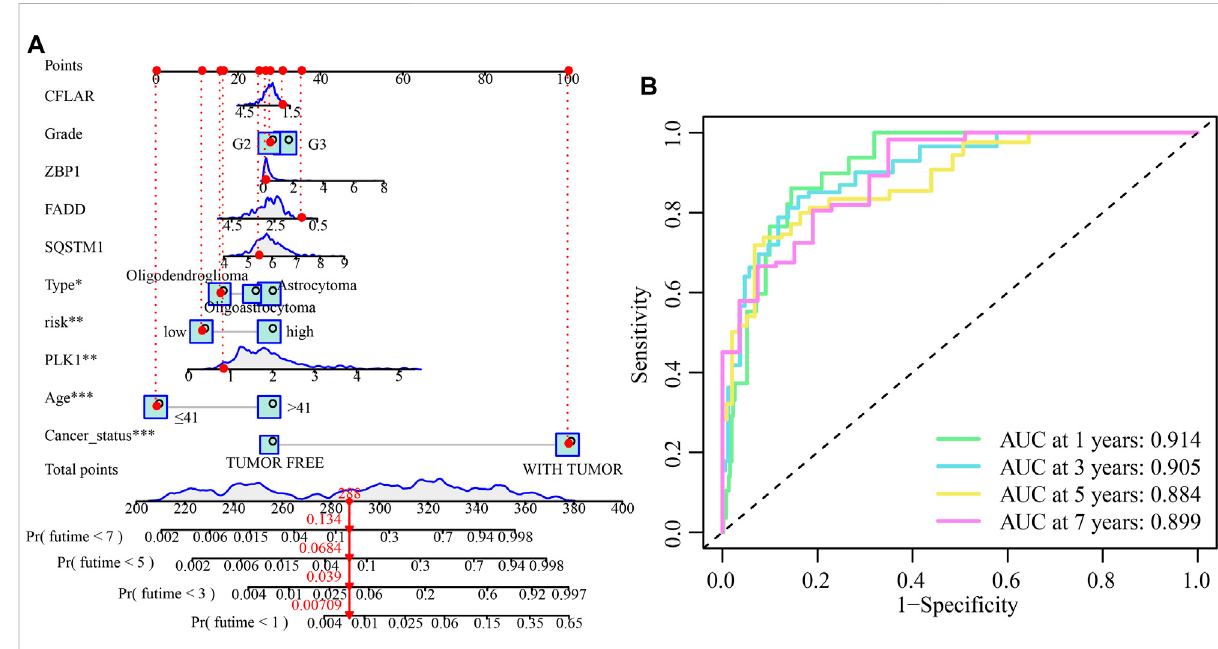
FIGURE 10 The developmentand validation oftherisk score-based nomogram. (A) A nomogramof LGG wasused to predict1-year, 3-year, 5-year, and 7- year survival rates. (B) The AUC values of the ROC curves for improved evaluation of the prognostic ability of the